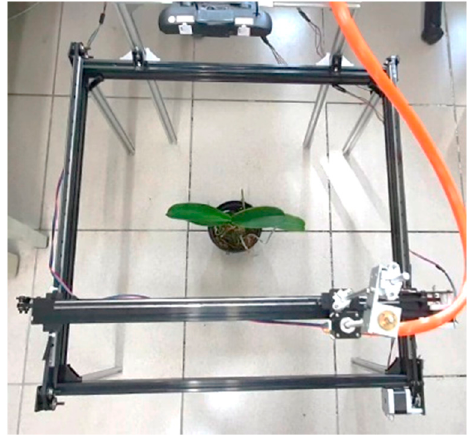
Figure 28. The configuration for the single-seedling experiments.